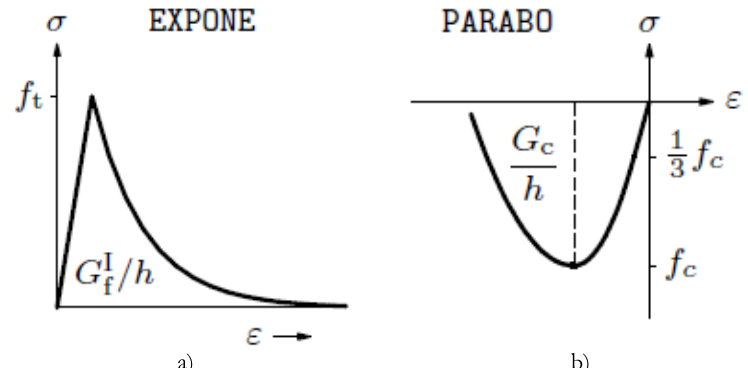
Figure 11: Nonlinear behavior of masonry: a) exponential softening in tension, b) parabolic hardening-softening in compression [19]. Three different types of masonry were identified in the building and represented in the FE model (Figure 10): (1) cut stone masonry with good texture, (2) stone masonry injected during past interventions, and (3) solid brick masonry. The